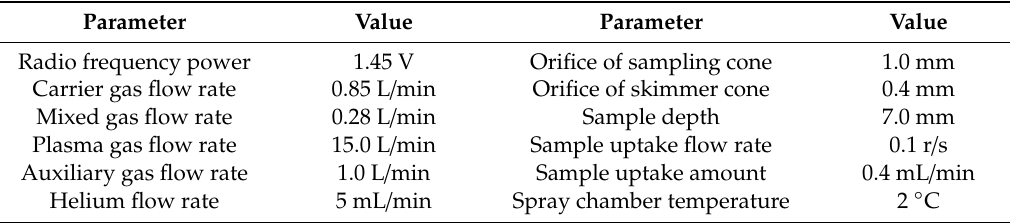
Table 2. 7900 ICP–MS operating